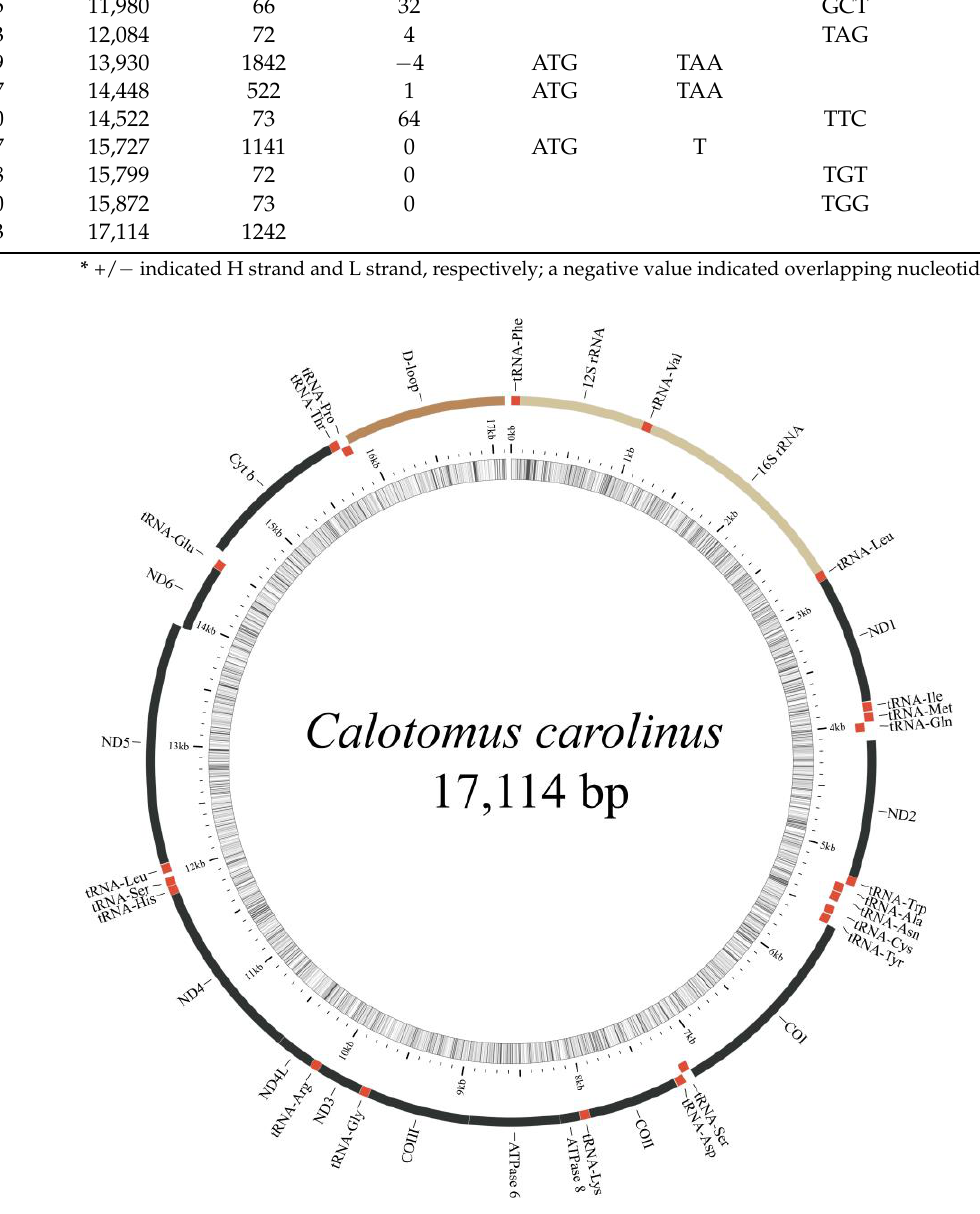
Figure 1. Organization of the parrotfish mitogenome. Calotomus carolinus was taken as an example. The inner ring indicated GC